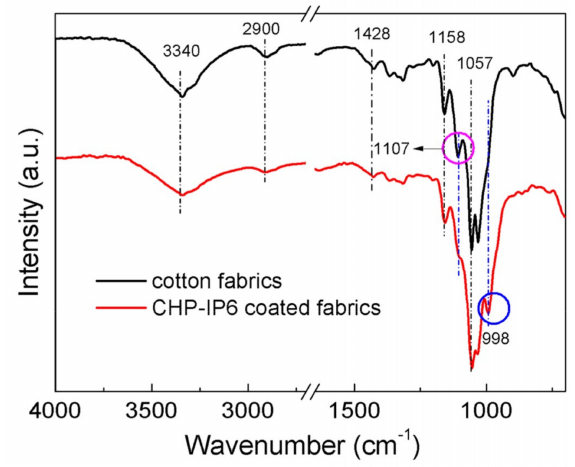
Figure 2. Fourier-transform infrared spectroscopy spectra of pristine and coated cotton